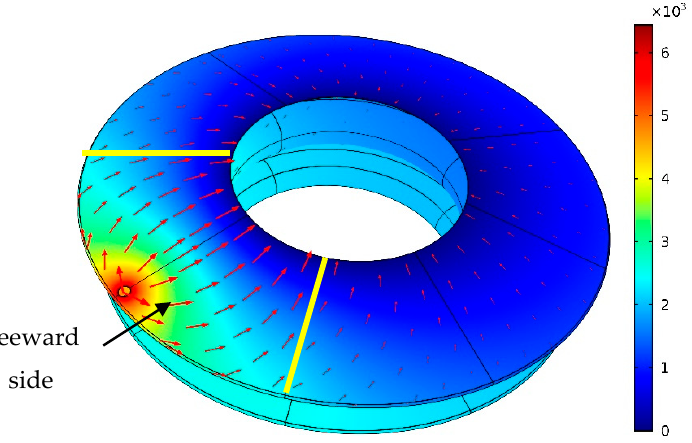
Figure 9. Distributions of the potential and current density lines.